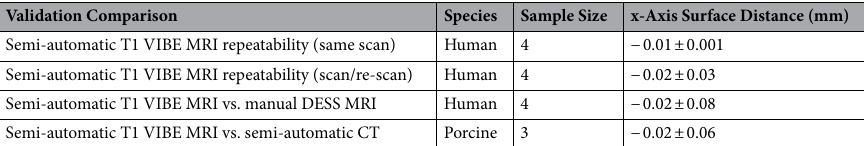
Table 2. Surface Distance Results for Each Validation Comparison. Data presented as mean ± standard deviation. T1 VIBE T1-weighted volume-interpolated breathhold examination with water excitation, DESS double echo steady-state, MRI magnetic resonance imaging, CT computed